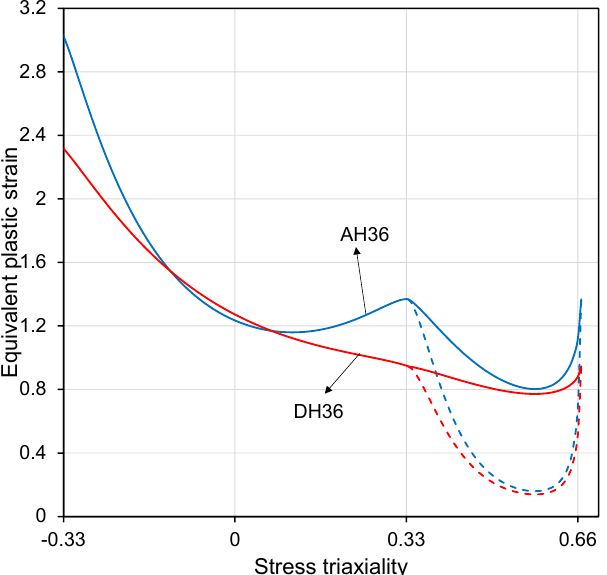
Figure 4. Localized necking (dashed line) and fracture (continuous line) loci of AH36 and DH36 grade